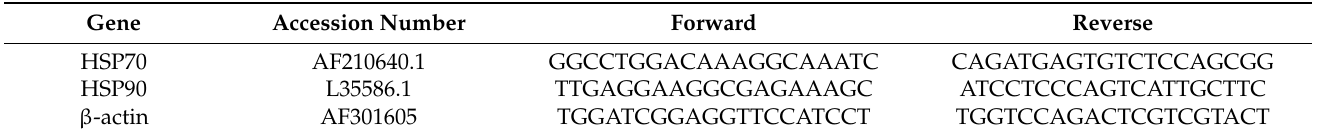
Table 2. Primers used in